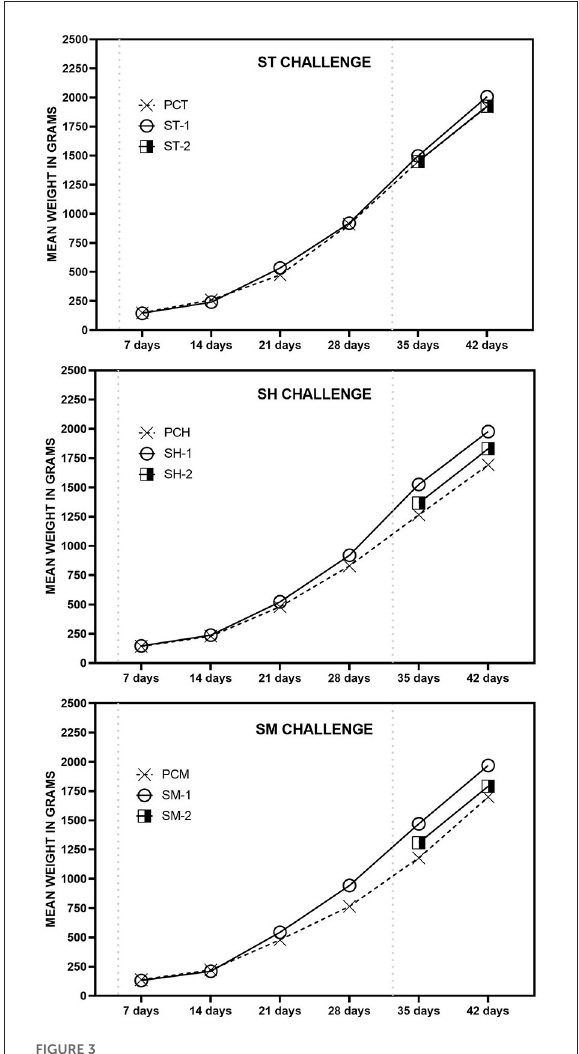
FIGURE3 Mean body weight in grams of broilers challenged ST, SH or SM, in treated and untreated groups at respective days-of-age.